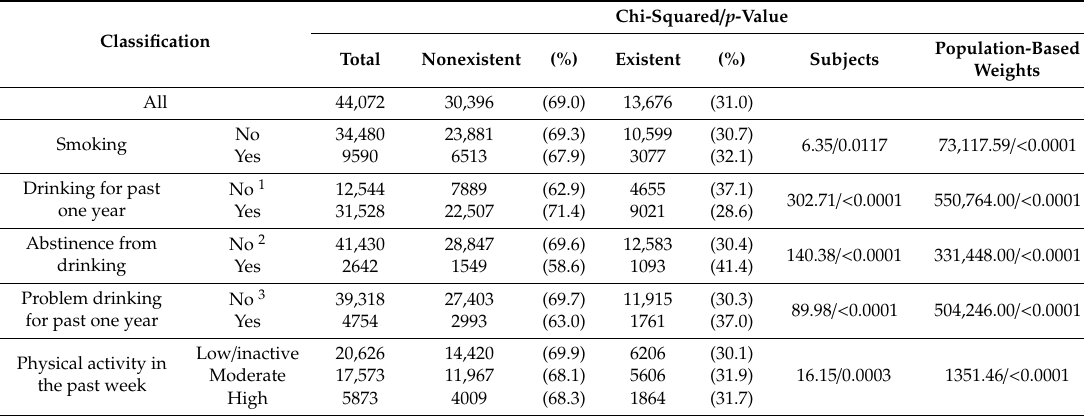
Table 3. Prevalence of food-chewing discomfort by health